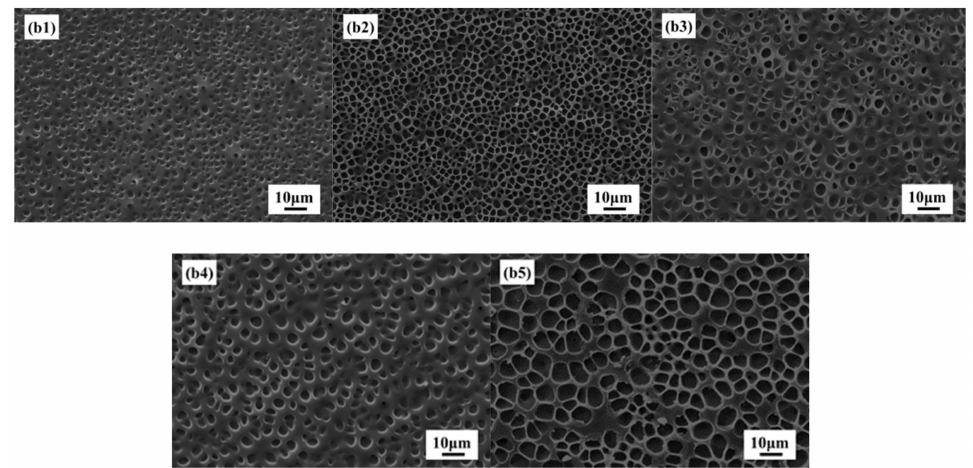
Figure 5. SEM images of ( b1 ) 45% LC; ( b2 ) 50% LC; ( b3 ) 55% LC; ( b4 ) 60% LC; ( b5 ) 65% LC.